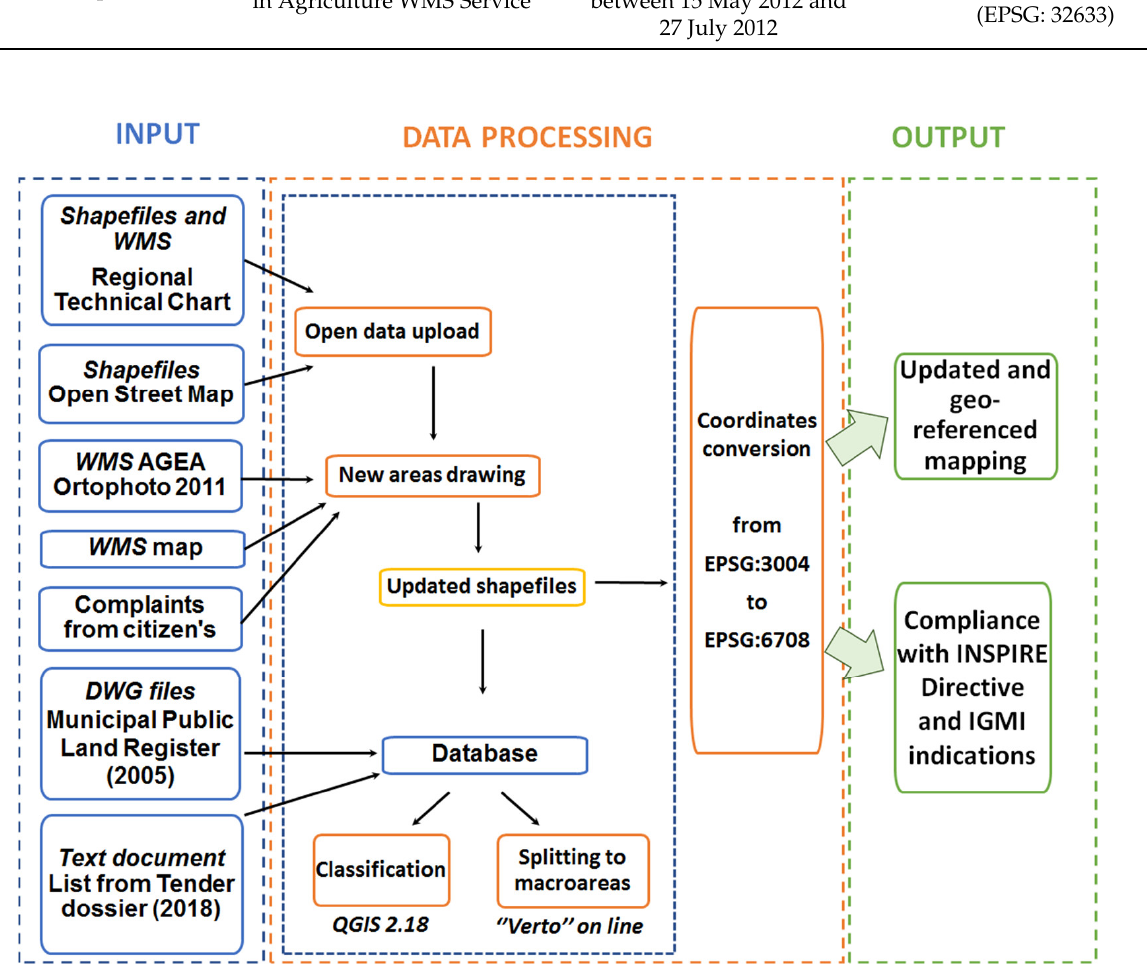
Figure 3. Flow chart of the operations for green areas mapping. Table 3. List of the types of UOS within the Municipality of Latina. Type and Description